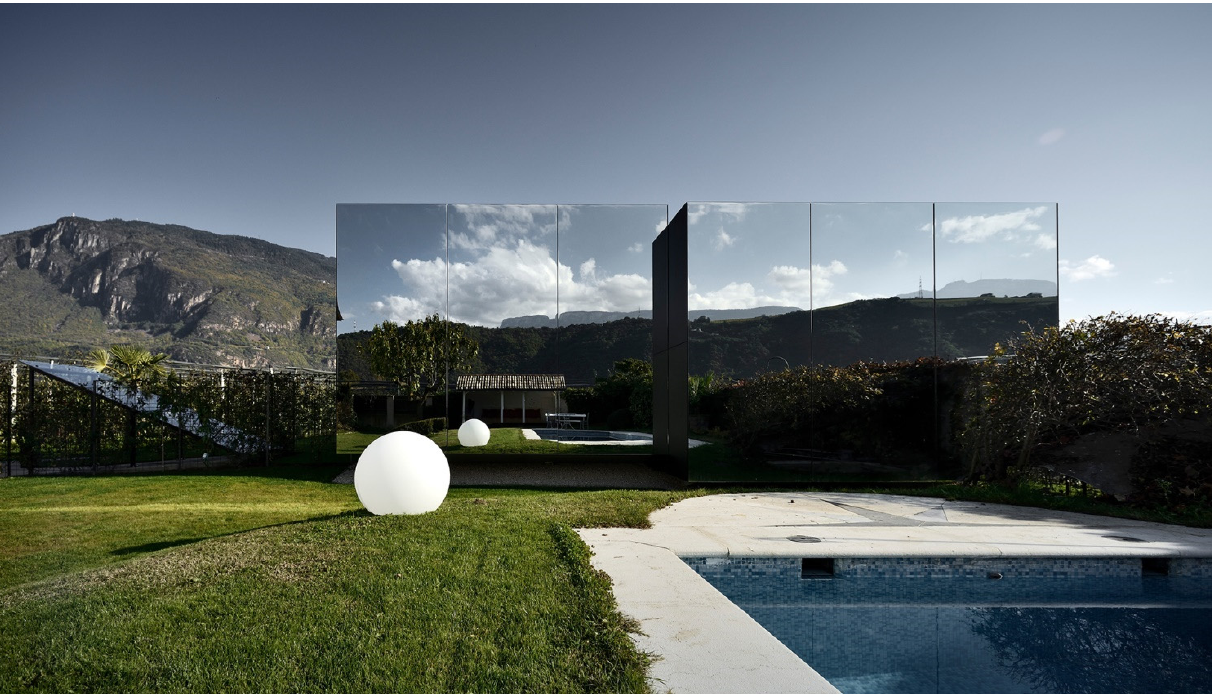
Figure 9. A mirror image of the Dolomite landscape on the facade of the Mirror Houses in Bolzano. Photo: © Oskar Da Riz. Photo: © Oskar Da